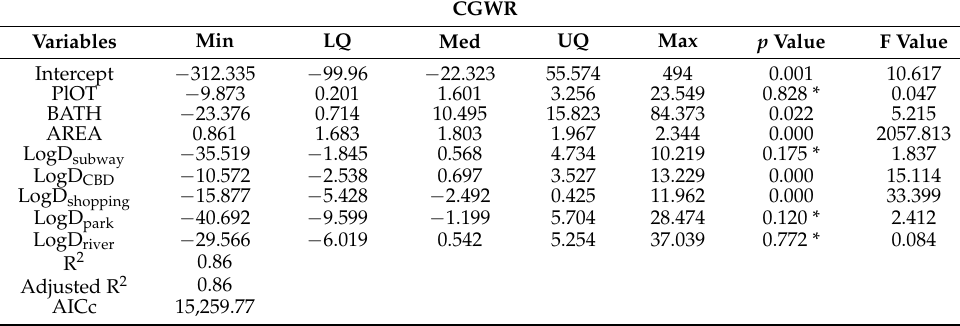
Table 5. The distribution of the localized coefficient estimates for the CGWR model (B = 2221 and ς =